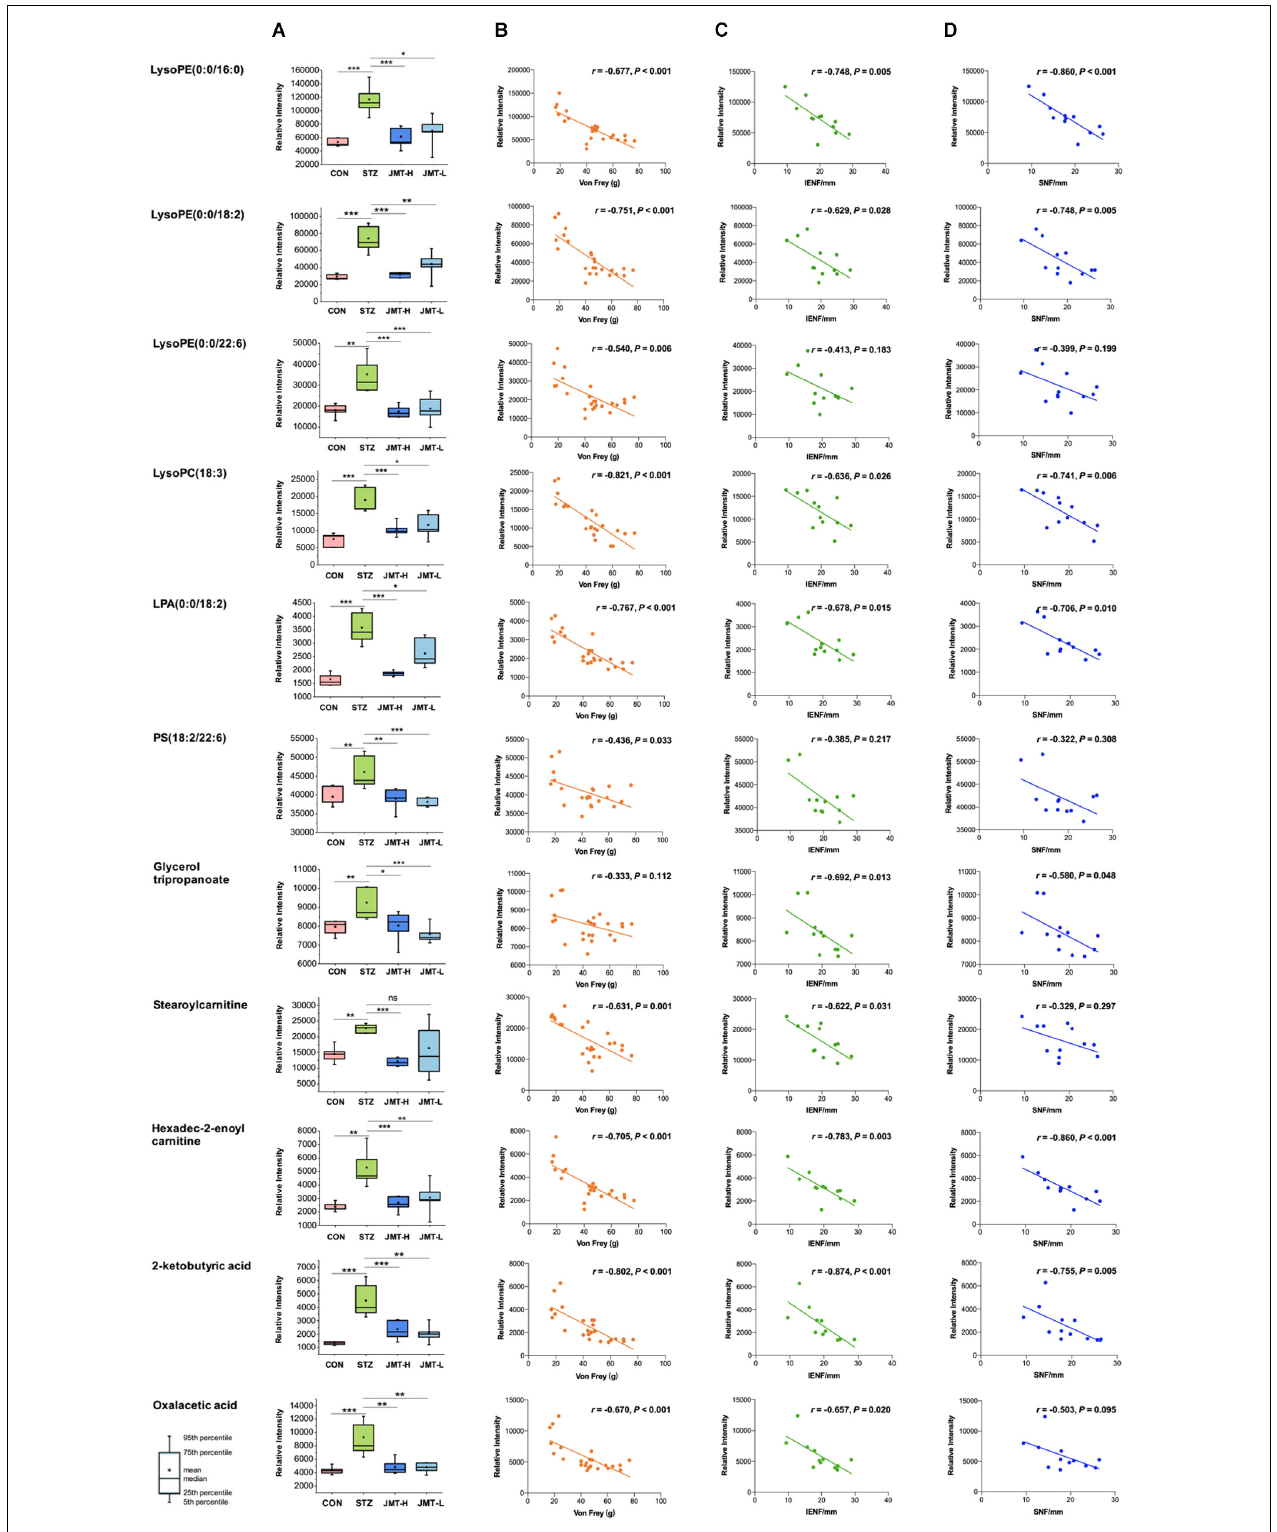
FIGURE 7 | Serum levels of identified biomarkers in different group (A) and their correlations with DPN efficacy indicators ( B , Von Frey; C , IENFD; D , SNFD) * P < 0.05, ** P < 0.01, and *** P < 0.005. (B) Ten metabolites were significantly negatively correlated with Von Frey ( P < 0.05). (C) Nine metabolites were significantly negatively correlated with IENFD ( P < 0.05). (D) Seven metabolites were significantly negatively correlated with SNFD ( P < 0.05).